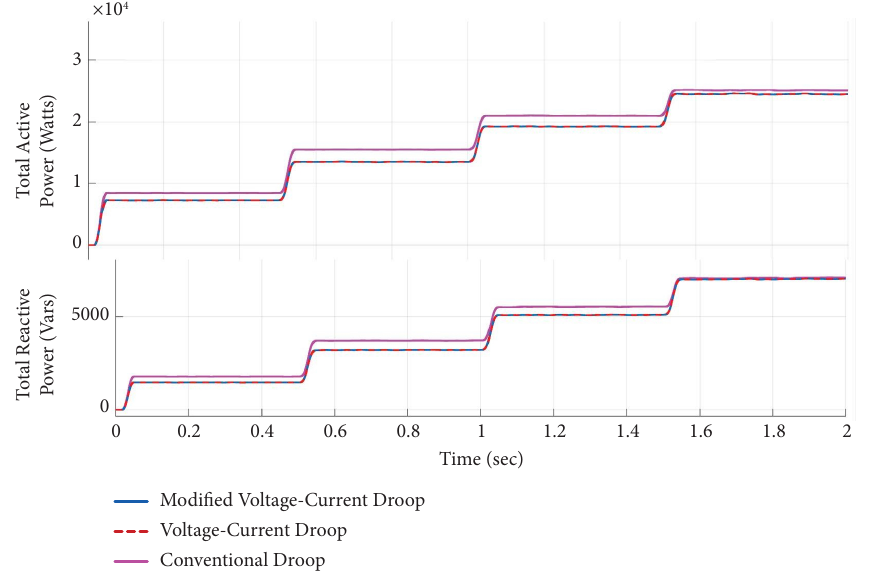
Figure 13: Representing power consumption of 5 bus test